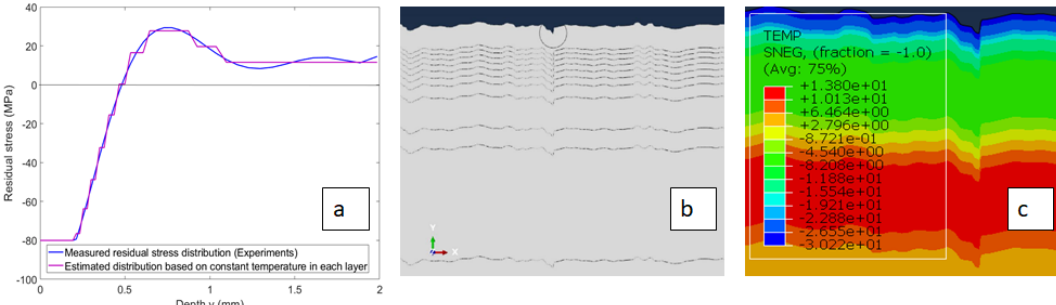
Figure 4. ( a ) Continuously approximated residual stress distribution (solid line) and discontinuously approximated residual stress distribution with constant values in each layer (stepwise continuous line) [27], ( b ) layer-wise global modeling, ( c ) the applied temperature field using the proposed approach.